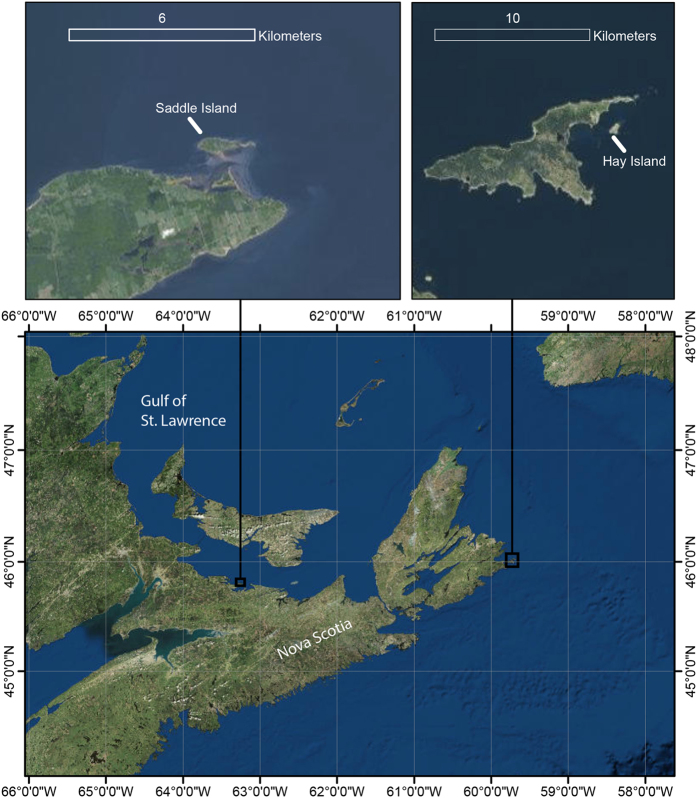
Locations of grey seal Halichoerus grypus breeding colonies on Saddle and Hay Island, Nova Scotia, Canada surveyed with unmanned aircraft systems (UAS) during January 29–February 2 2015.This map was created with ArcMap GIS software (version 10.4.1, Esri Inc.) using ArcMap’s World Imagery service layer. Service Layer Credits: Source: Esri, Digital Globe, GeoEye, Earthstar, Geographics, CNES/Airbus DS, USDA, USGS, AEX, Getmapping, Aerogrid, IGN, IGP, swisstopo and the GIS user community.